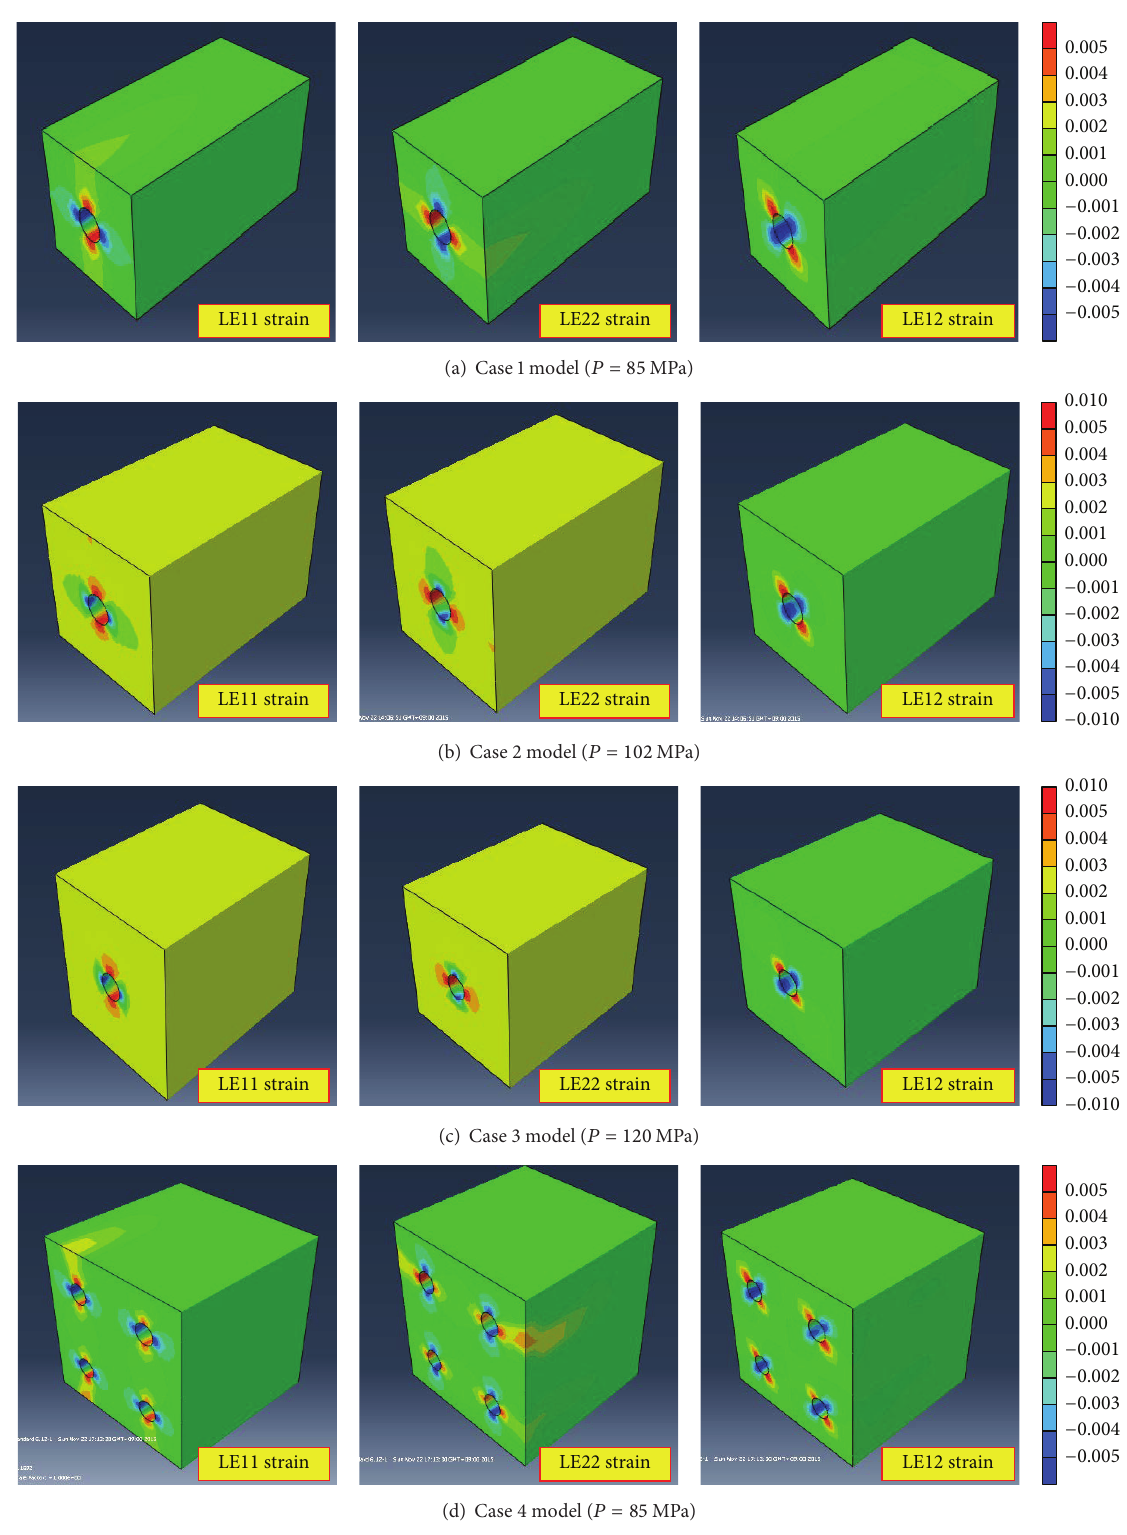
Figure 12: Strain field contours under initial cracking pressure for individual test